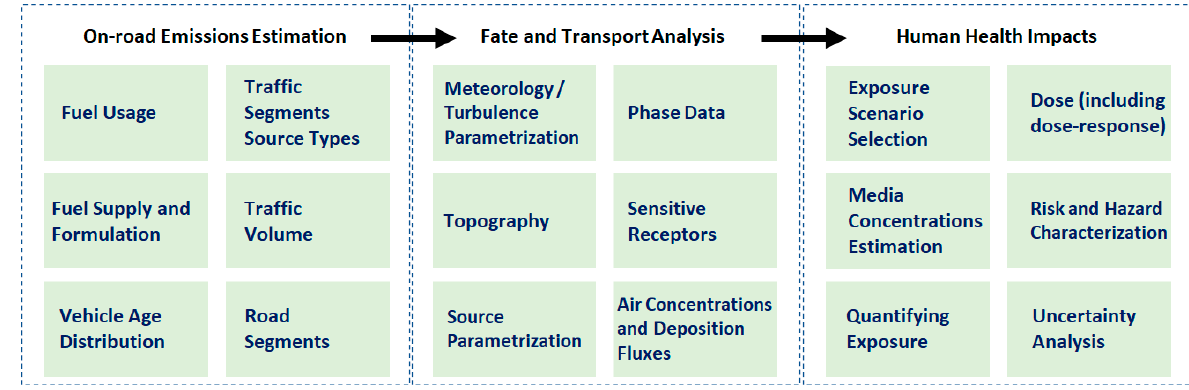
Figure 1. Flowchart of the Proposed Methodology .